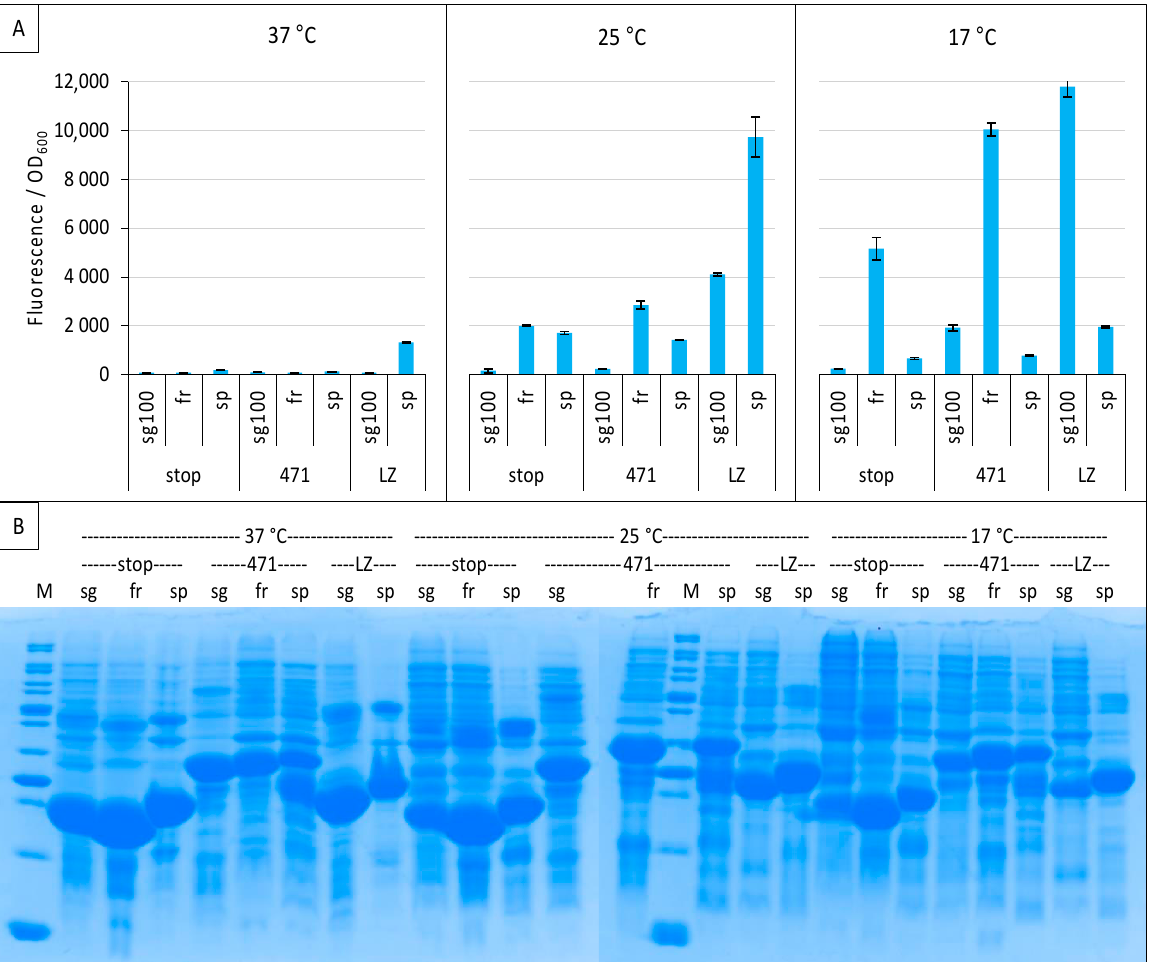
Figure 4. Comparison of sg100, fr and sp GFP variants at different temperatures. Split-GFP reassembly assay results as obtained with the negative (stop) and positive (471) controls of the 471/XD interaction with sg100, fr and sp GFP reporters at 37 ◦ C, 25 ◦ C and 17 ◦ C. The interaction between leucine zippers (LZ) is included for sg100 and sp. ( A ) Fluorescence to OD 600 ratios. ( B ) SDS-PAGE analysis of the expression of the NGFP fusions. M, molecular size markers (200, 150, 100, 85, 70, 60, 50, 40, 30, 25, 20, 15, 10